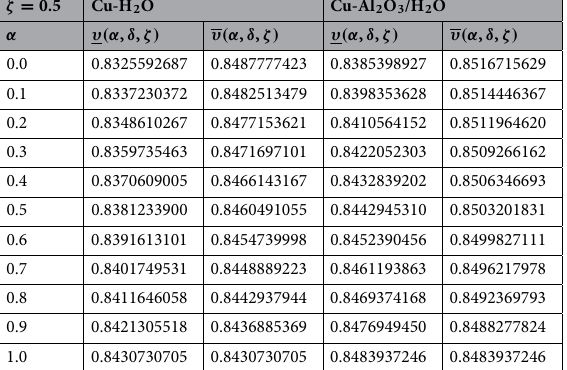
Table 9. Fuzzy velocity distribution of lower and upper bound in converging channel for various values of α and ζ = 0.5, Ha = 75, Re = 80, ω = − 5 0 .